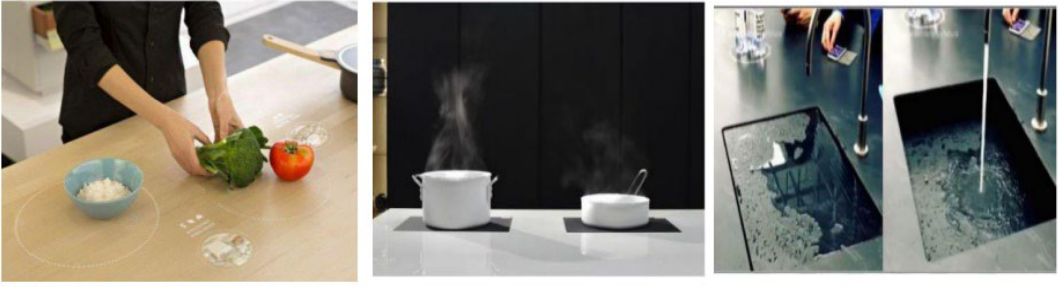
Figure 8 Invisible Sink designed by Offmat Kitchen Concept (Business Insider, 2016).